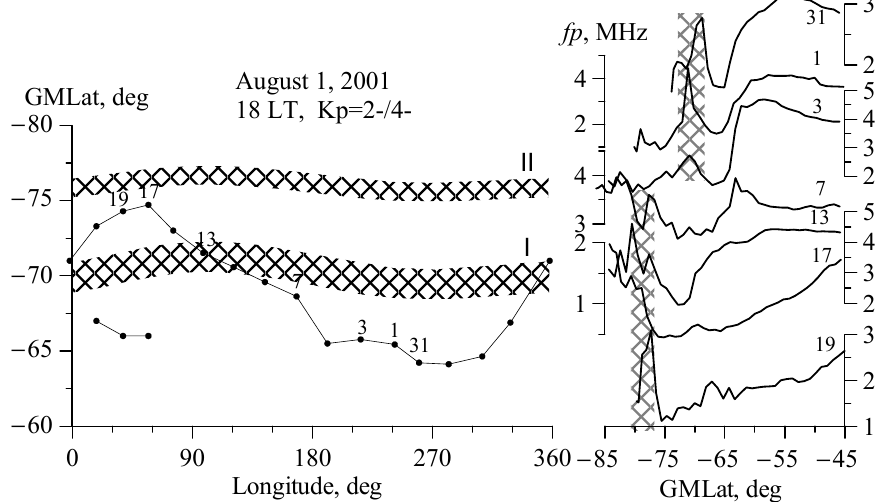
Figure 3. ( Left ): Longitudinal variations in the trough position on 1 August 2001. Precipitation zones I and II are hatched. ( Right ): Latitudinal fp profiles for the paths marked on the left. Examples of the latitudinal cross-sections of the MIT are shown in Figure 3 on the right for paths 31, 1 and 3. The trough on these paths is clearly expressed; its poleward wall exactly corresponds to zone I of precipitation at a latitude of approximately − 70°. In the eastern hemisphere, the troughs on paths 13 ‒ 23 are located inside the auroral oval and by definition belong to the HLT. Examples of well-formed HLTs are shown on the right for paths 13, 17 and 19. Their poleward walls are located at latitudes of 76° ‒ 80°, i.e., they are formed by precipitation in zone II. Path 7 is transitional; the poleward wall of the trough corresponds to zone II of precipitation, and the electron density minima at its wide bottom corresponds to both MIT and HLT. On paths 17 and 19, weak variations in iono- spheric plasma are observed in the latitudinal region at approximately − 66°, which can be